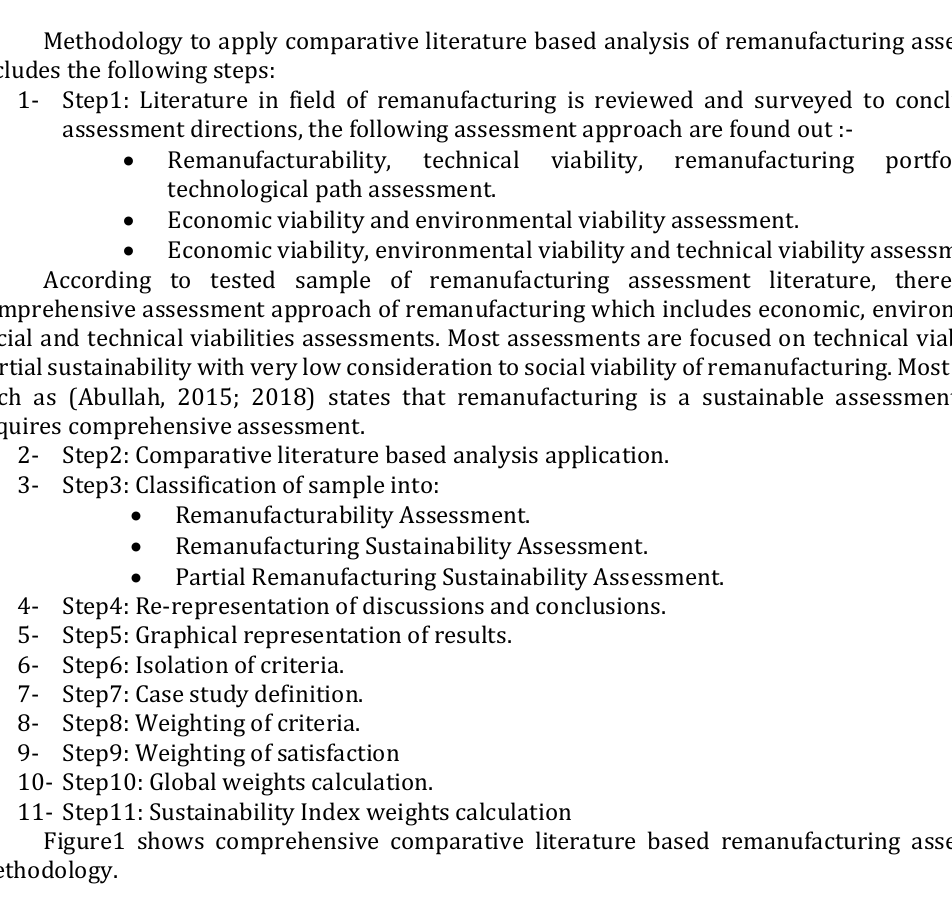
Figure 24: Comparative literature based assessment application